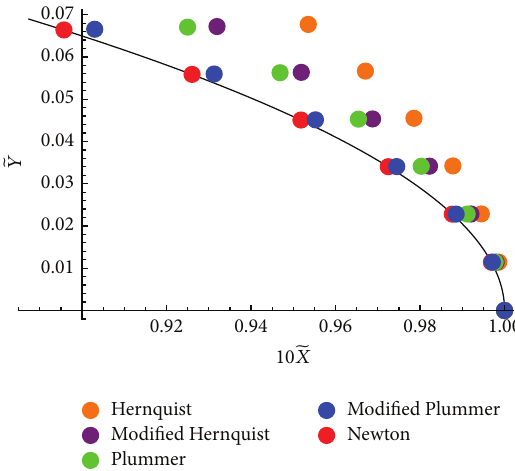
Figure 1: Trajectories for different